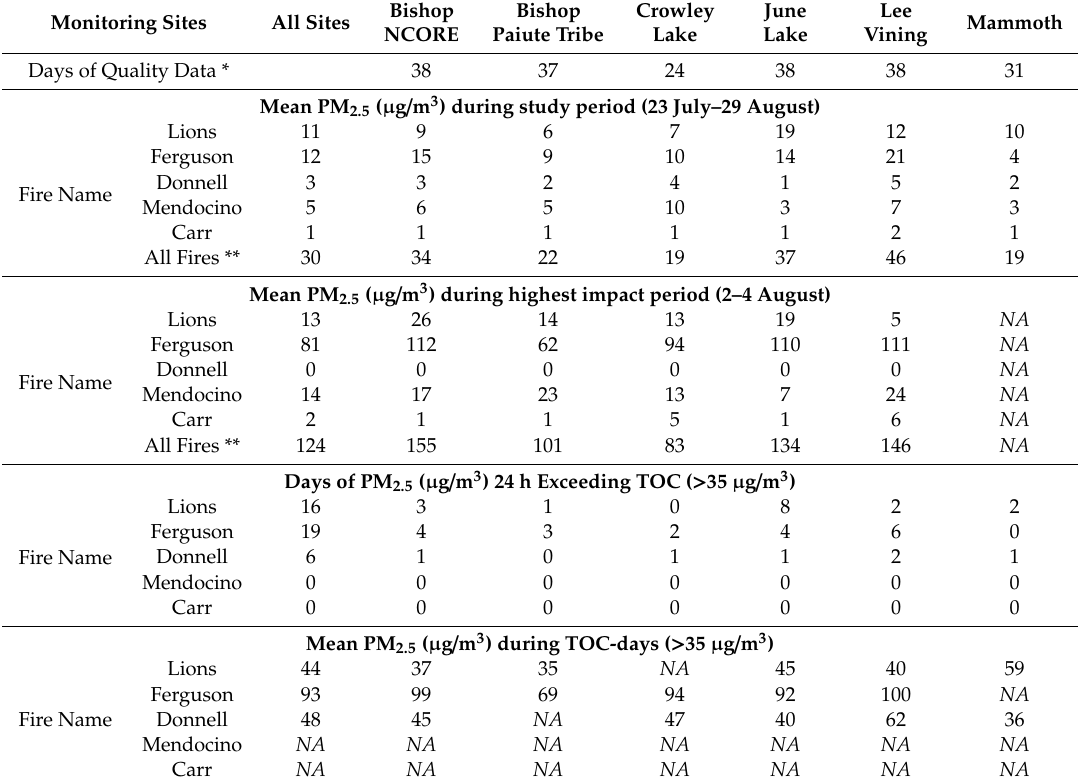
Table 1. Comparisons of modeled smoke apportionment and impacts per air quality monitoring site and per fire. Individual data points are rounded to the nearest whole